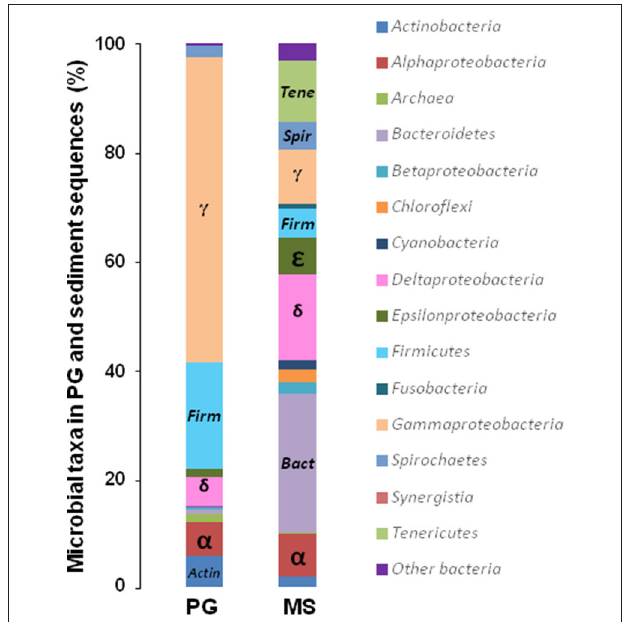
FIGURE 1 | Compositions of microbial communities in the coastal marine sediment and phosphogypsum samples of Sfax (Tunisia). Relative phylogenetic abundance was based on frequencies of 16S rRNA gene sequences affiliated with Archaea and major bacterial phyla or proteobacterial classes in the microbial communities of marine sediment (MS) and phosphogypsum